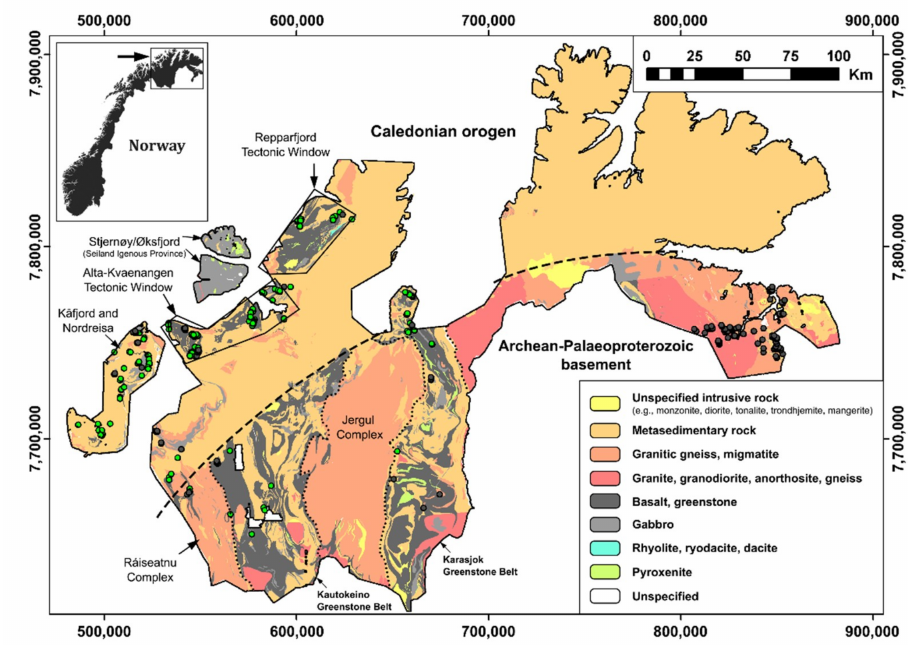
Figure 2. Geology of the studied area in Finnmark. The location of known Cu-rich deposits and other types of deposits are indicated in green and dark grey circles, respectively (see Table 1 for details). The dashed black lines delimit the northern Caledonian orogen from the southern Archean schist and gneiss complexes and Palaeoproterozoic sedimentary, volcanic and plutonic rocks (based on [19]). The dotted lines delineate boundaries between the greenstone belts and the Archean gneiss complexes. UTM zone 34, European Datum